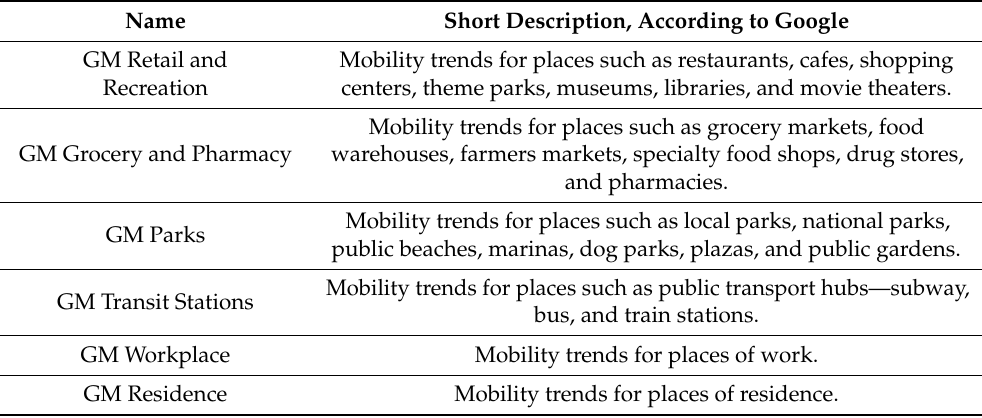
Table 1. Short description of Google Mobility (GM)